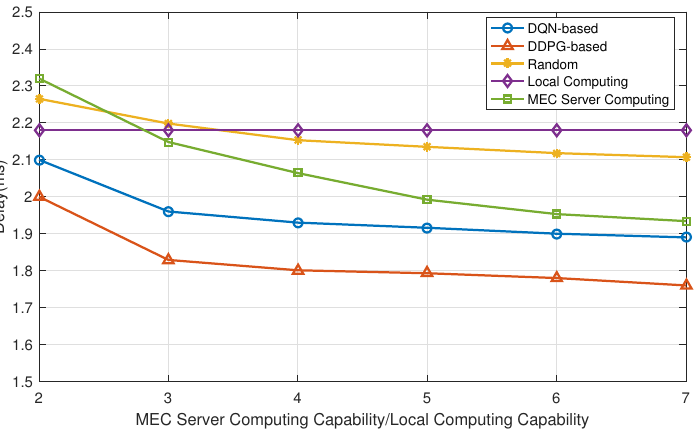
Figure 10. The delay comparison under different computing capabilities, where the red curve repre- sents the delay of the DDPG-based computational offloading paradigm, the blue curve represents the delay of the DQN-based computational offloading paradigm, the yellow curve represents the delay of the “Random” policy, the purple curve represents the delay of the “Local computing” policy, and the green curve represents the delay of the “MEC server computing” policy.